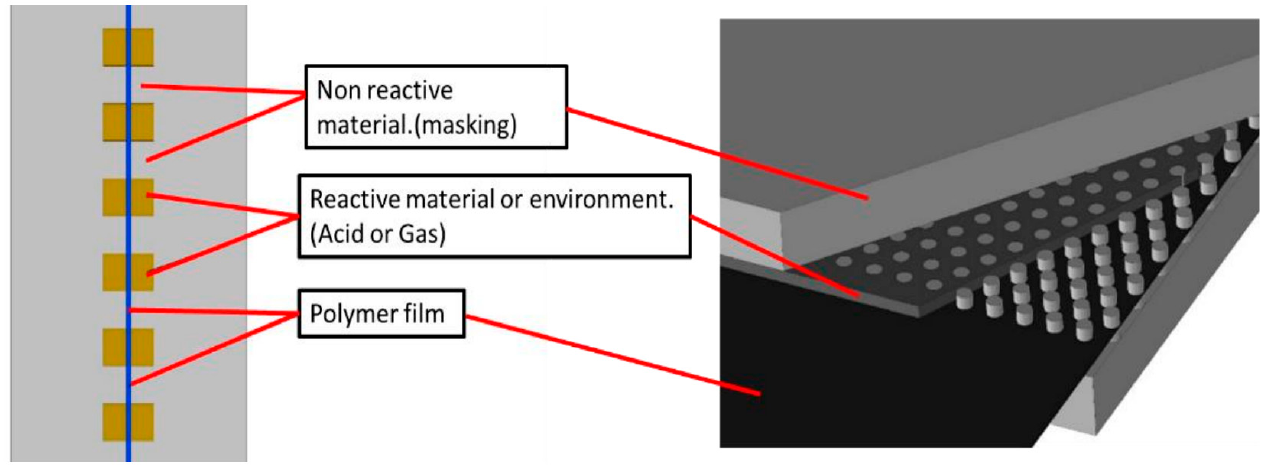
Figure 1. Photograph of the PTFE machined clamp: setup for masked stabilization and complete view of the pins and fluid